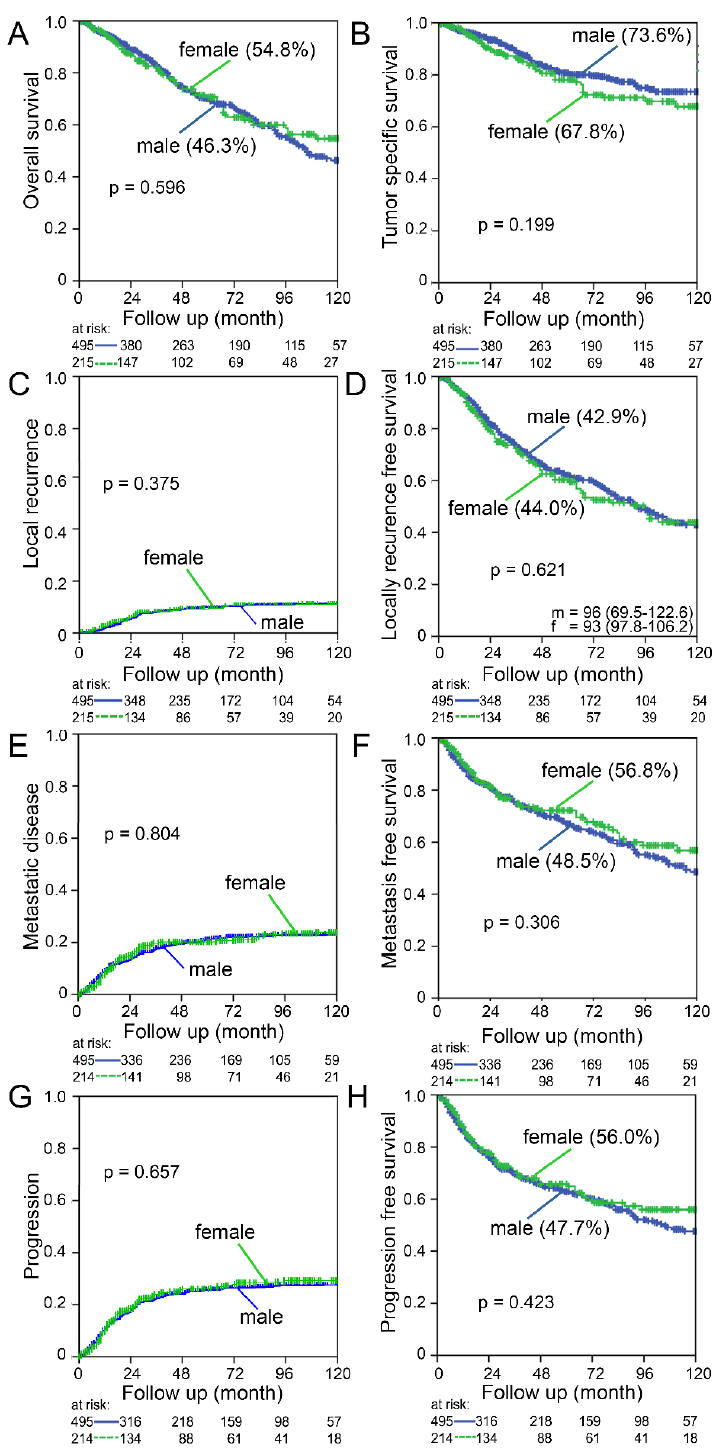
Figure 10. Ten year follow-up of male and female patients suffering from rectal cancer of the entire cohort: ( A ) Overall survival; ( B ) Tumor-specific survival; ( C ) Cumulative incidence of local recurrence; ( D ) Local recurrence-free survival; ( E ) Cumulative incidence of metastatic disease; ( F ) Metastasis-free survival; ( G ) Cumulative incidence of any recurrence and ( H ) Progression-free survival. The 10-year survival is given in brackets. Log-rank test was used to calculate p -values.